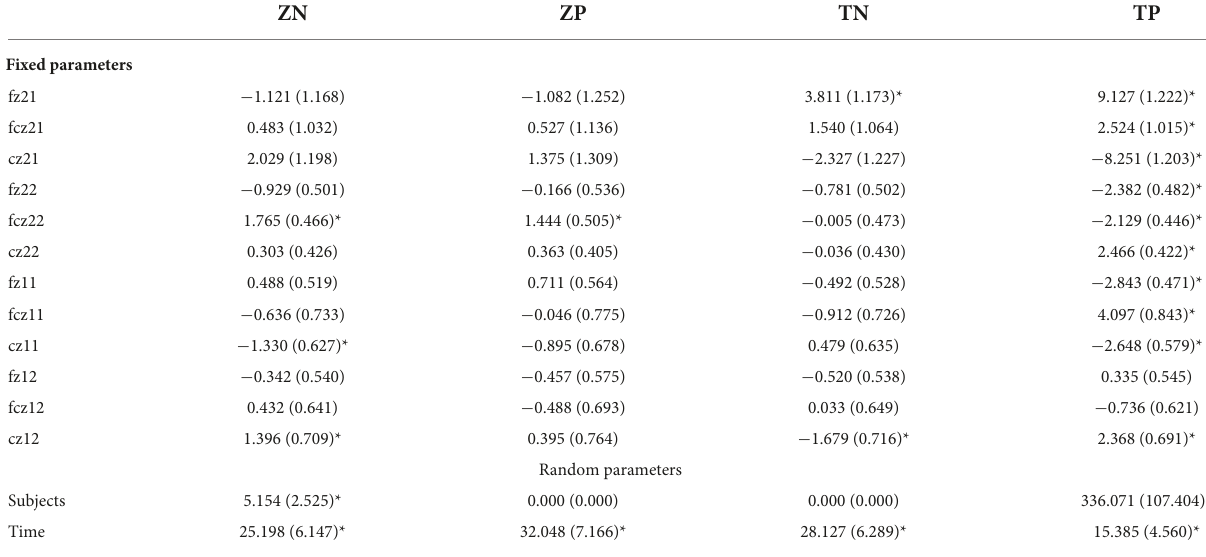
TABLE 6 The correlations analysis between ERP N1 component and accuracy rates on pain empathy paradigm. ZN ZP TN TP